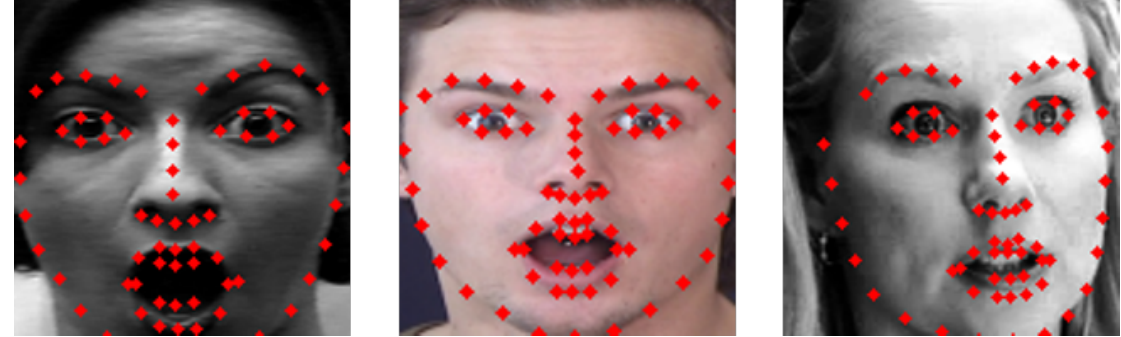
Figure 6. Examples of 68 landmarks detection: ( Left ) CK+; ( Middle ) MMI; and ( Right )